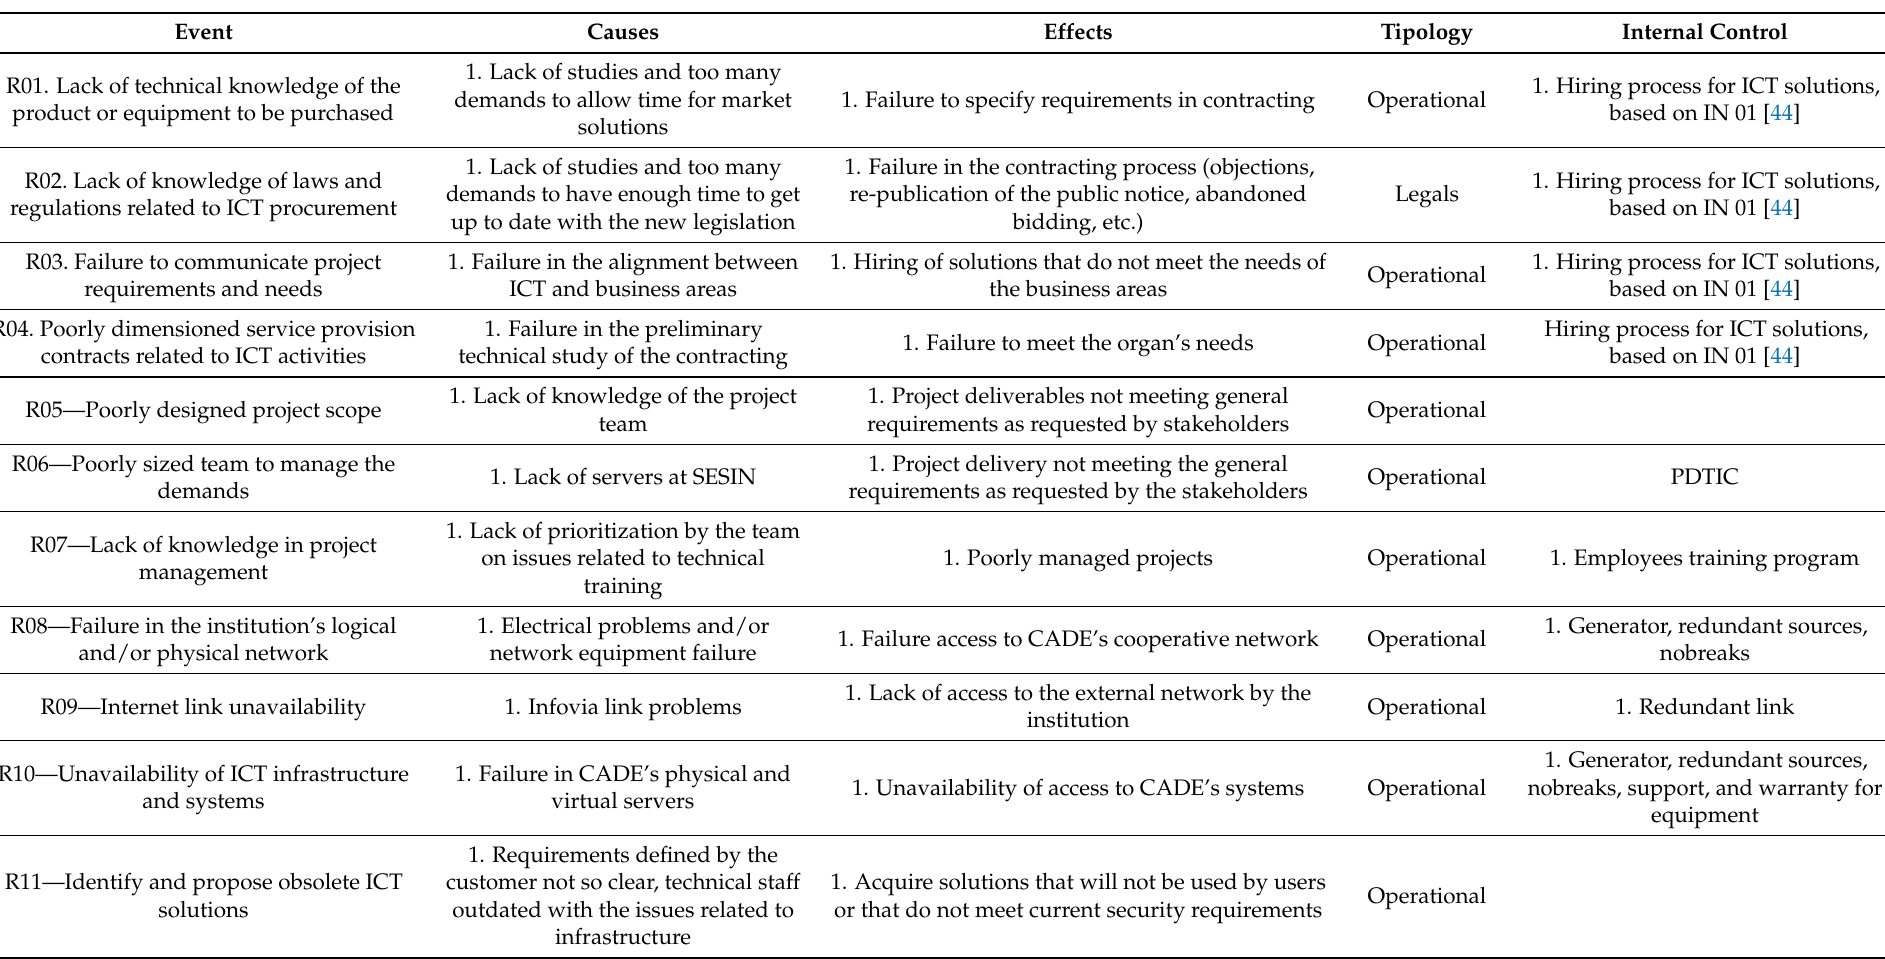
Table 2. Risk events identified in the Provide ICT Infrastructure